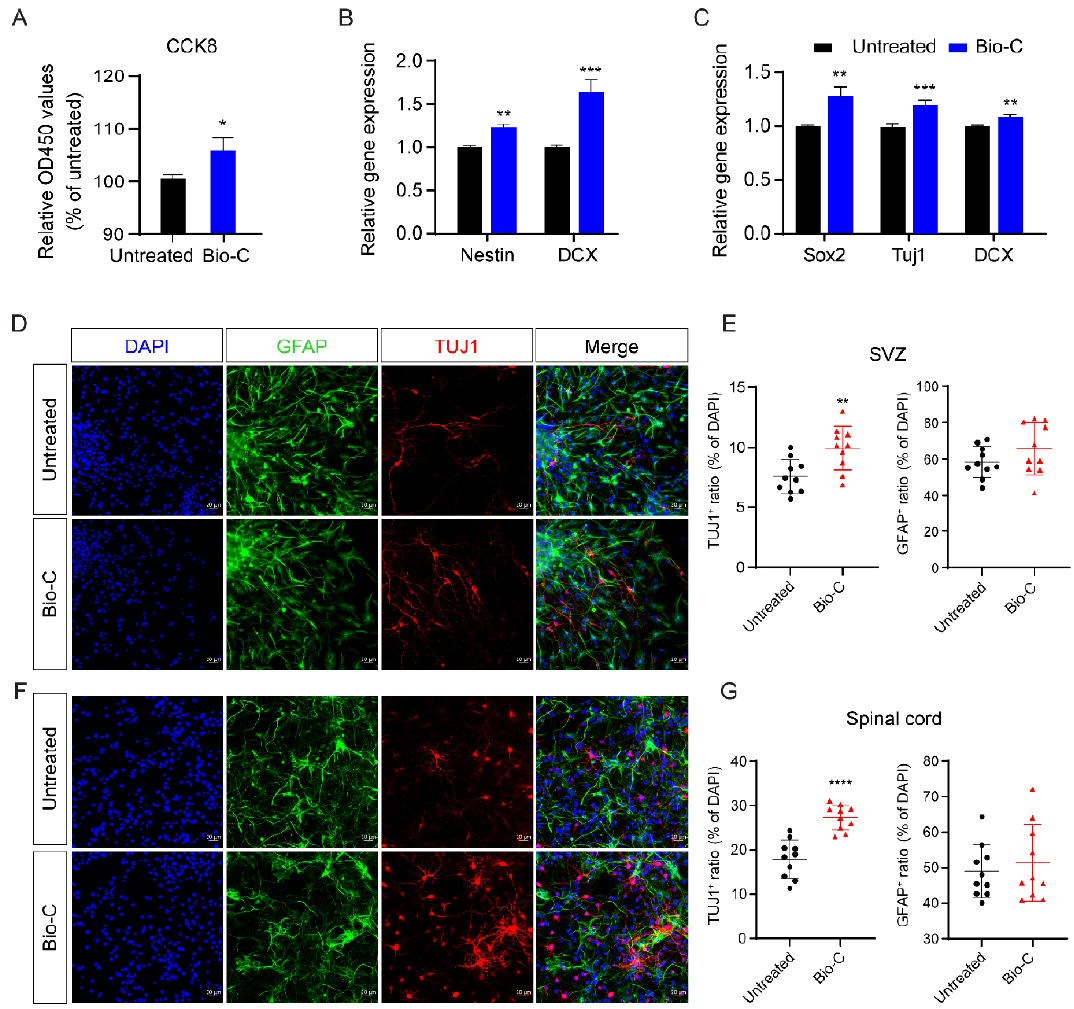
Figure 4. Bio-C improved NSCs growth and enhanced NSCs differentiation into neurons in vitro.